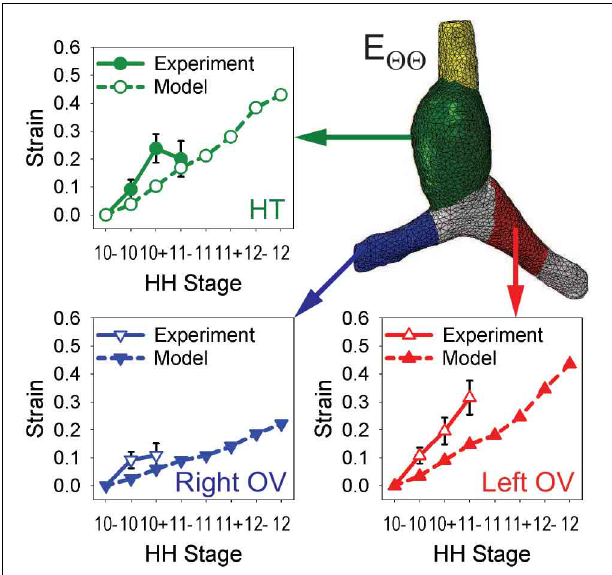
FIGURE 8 | Effects of inhibiting contraction or vein fusion. (A) Straight heart tube (HT) at HH10-. To help visualize the deformation, artificial markers are placed along the ventral midline. (B) Baseline (control) model loops to the right at HH12. (C) Baseline model with cytoskeletal contraction turned off in the splanchnopleure, foregut, and the caudal sides of the omphalomesenteric veins (OVs) around the anterior intestinal portal. Consistent with experiments (Rémond et al., 2006), the heart loops relatively normally without contraction. (D,E) Baseline model with simulated OV fusion (uniform longitudinal growth in HT) turned off. Along the dorsal side of the HT, the dorsal mesocardium (DM) is either (D) ruptured (free) or (E) attached to the foregut (roller). Without OV fusion, the heart undergoes less bending and rotation than control (D) . With the DM further constrained (E) , relatively little rightward rotation occurs, and compression causes the cranial side of the left OV to buckle (arrowheads). (F) Buckled left OV in HH9 embryo exposed to 30 μ M blebbistatin cultured for 20h (see Supplementary Figure S1). Scale bar: 200 μ